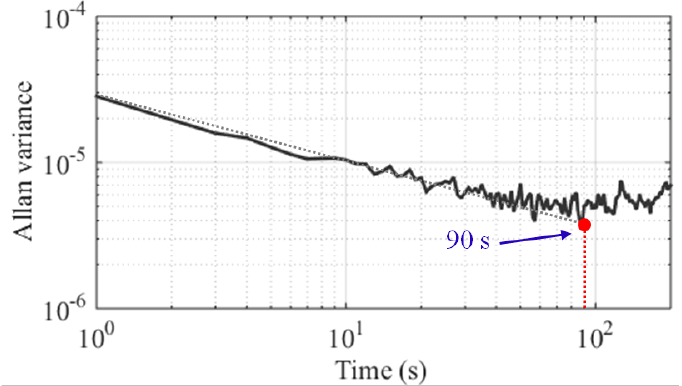
Figure 13. Allan variance of the new system as a function of integration time. The grey and red dashed lines are used to obtain the maximum available averaging time of 90 s.